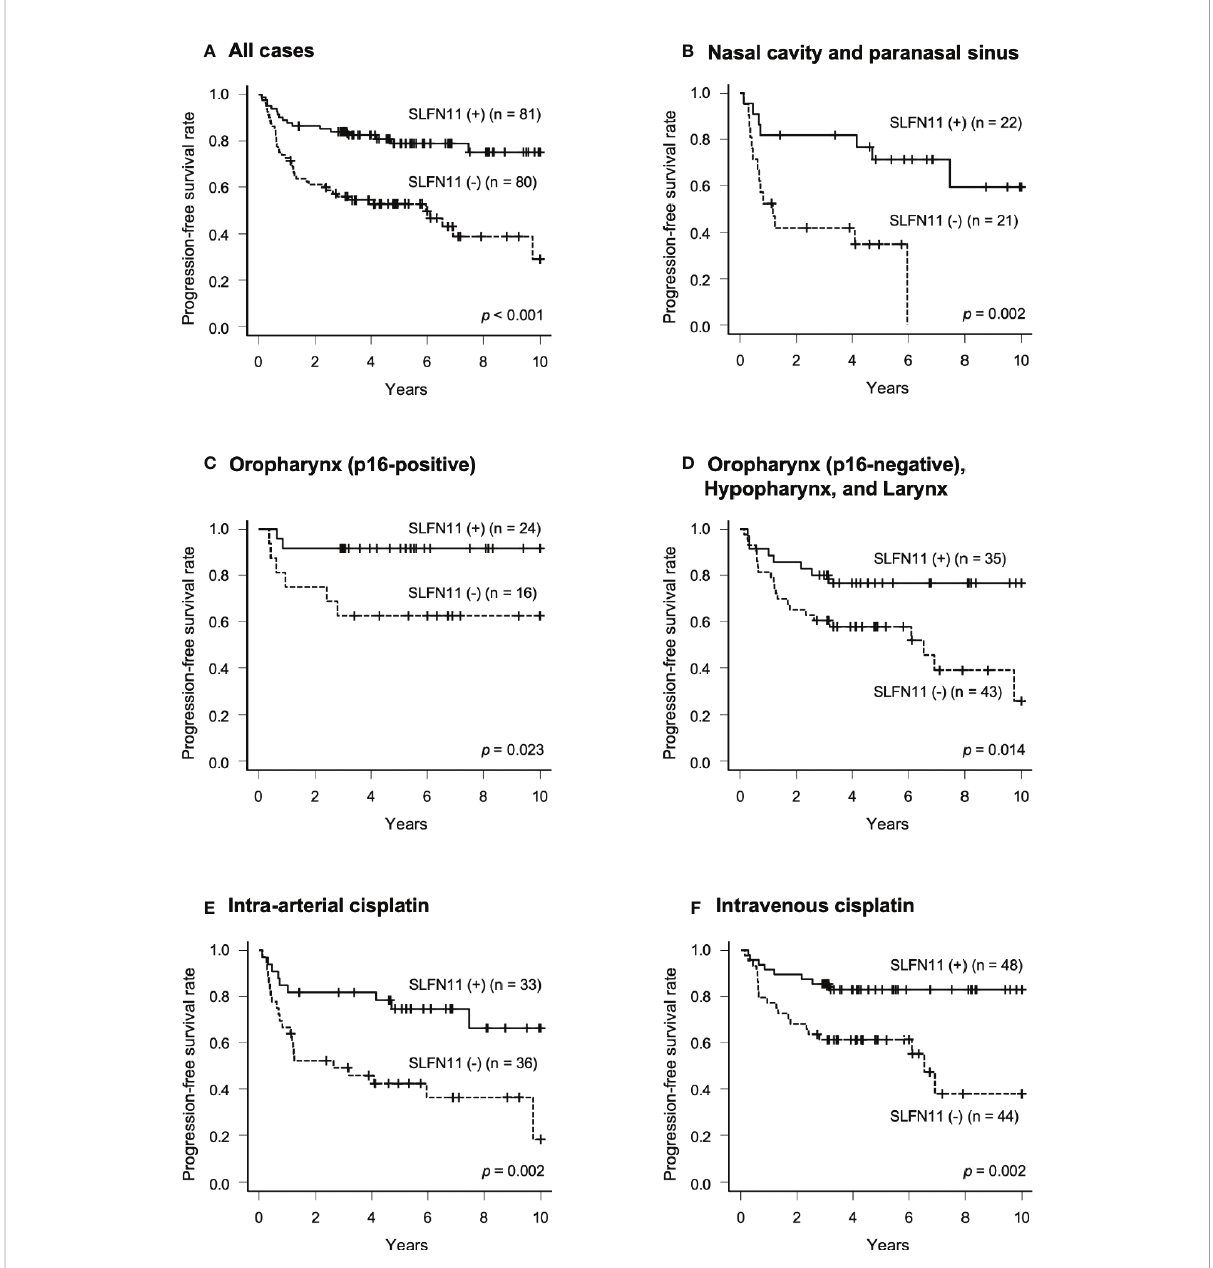
FIGURE 2 Progression-free survival (PFS) in patients with SLFN11-positive HNSCC. PFS curves generated by the Kaplan – Meier method are shown for all 161 patients in (A) and those with tumors arising from each primary site are indicated at the top of the panel in (B – D) . Intra-arterial and intravenous cisplatin were analyzed separately in (E, F) . The difference between groups was calculated using the log-rank